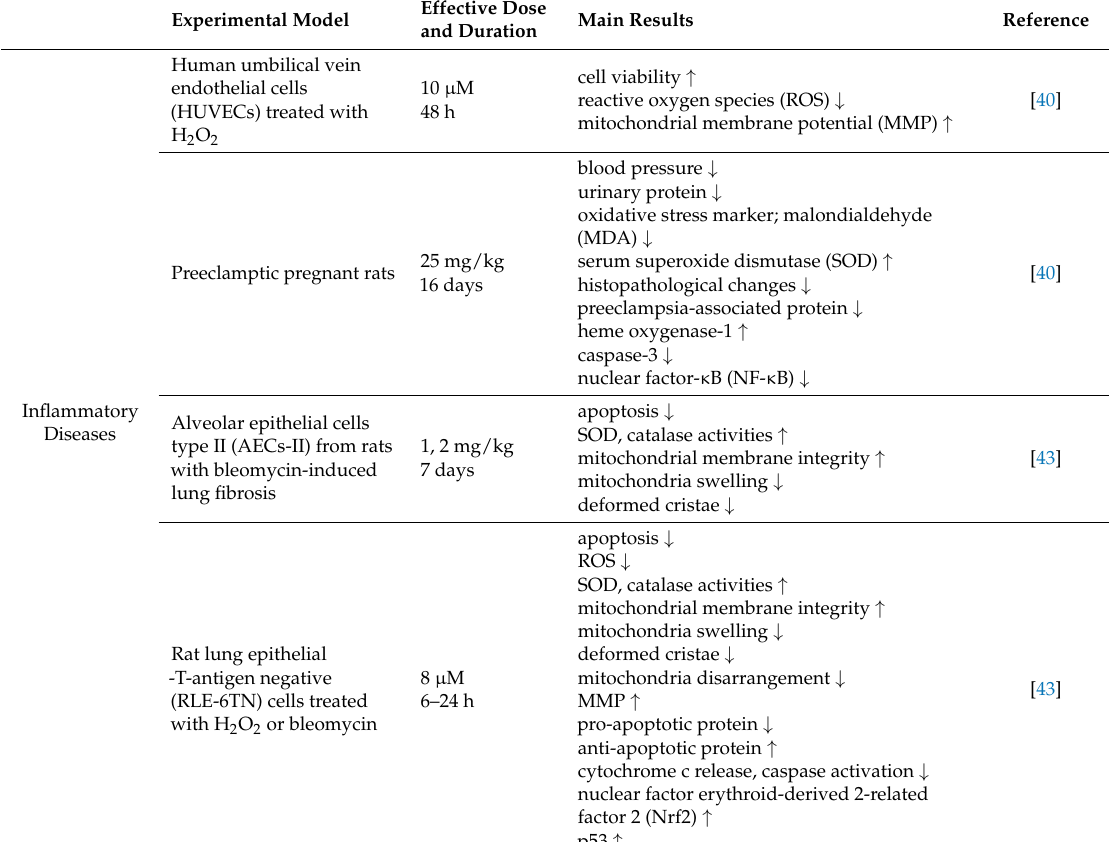
Table 1. In vitro and in vivo studies on the effect of astaxanthin on oxidative stress-associated diseases and mitochondrial